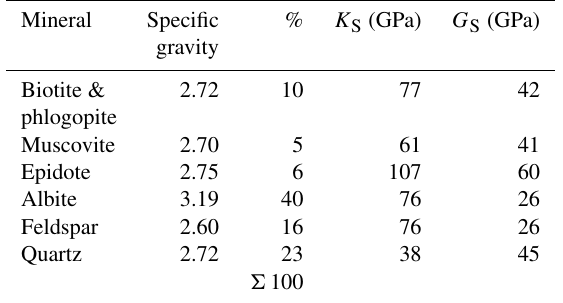
Table 6. Mineralogical fractions of the Grimsel granite (data ob- tained by Wenning et al., 2018, Institute of Geology, ETH, Zurich). Mineral